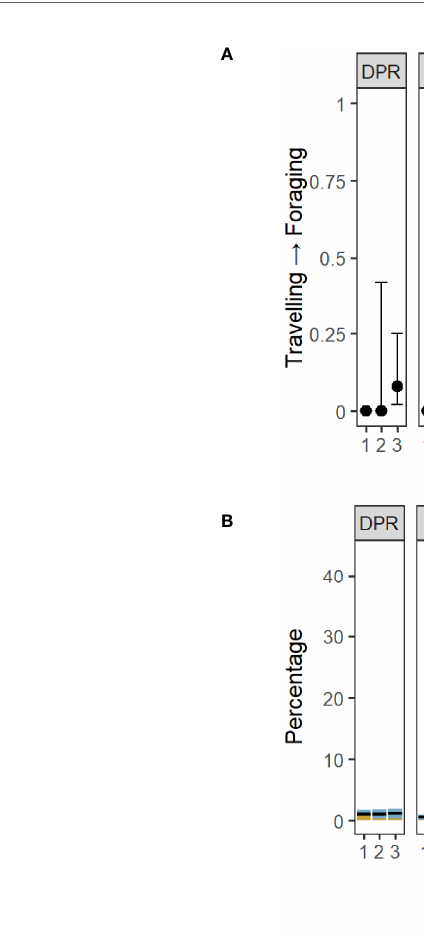
( Figure 5 ). Slopes exposed to currents (e.g. on the fringes of the